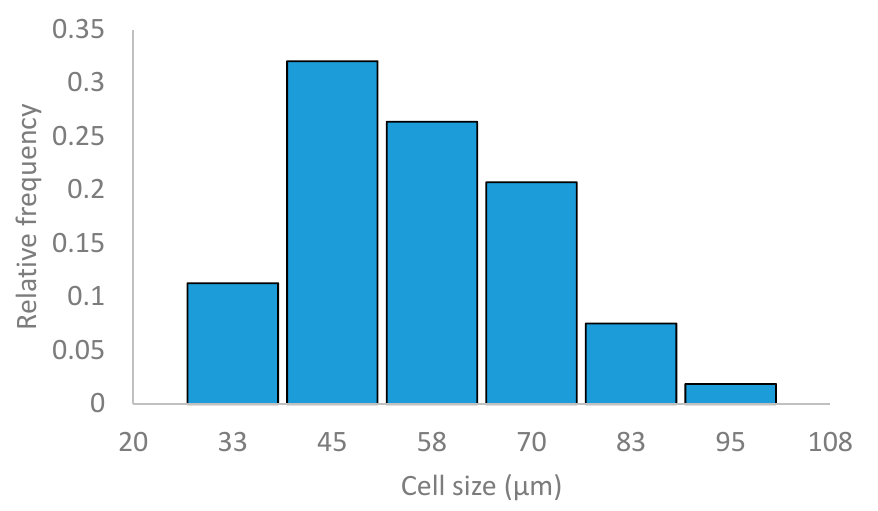
Figure 6. Cell size frequency distribution of dry lyophilized starch raw material.